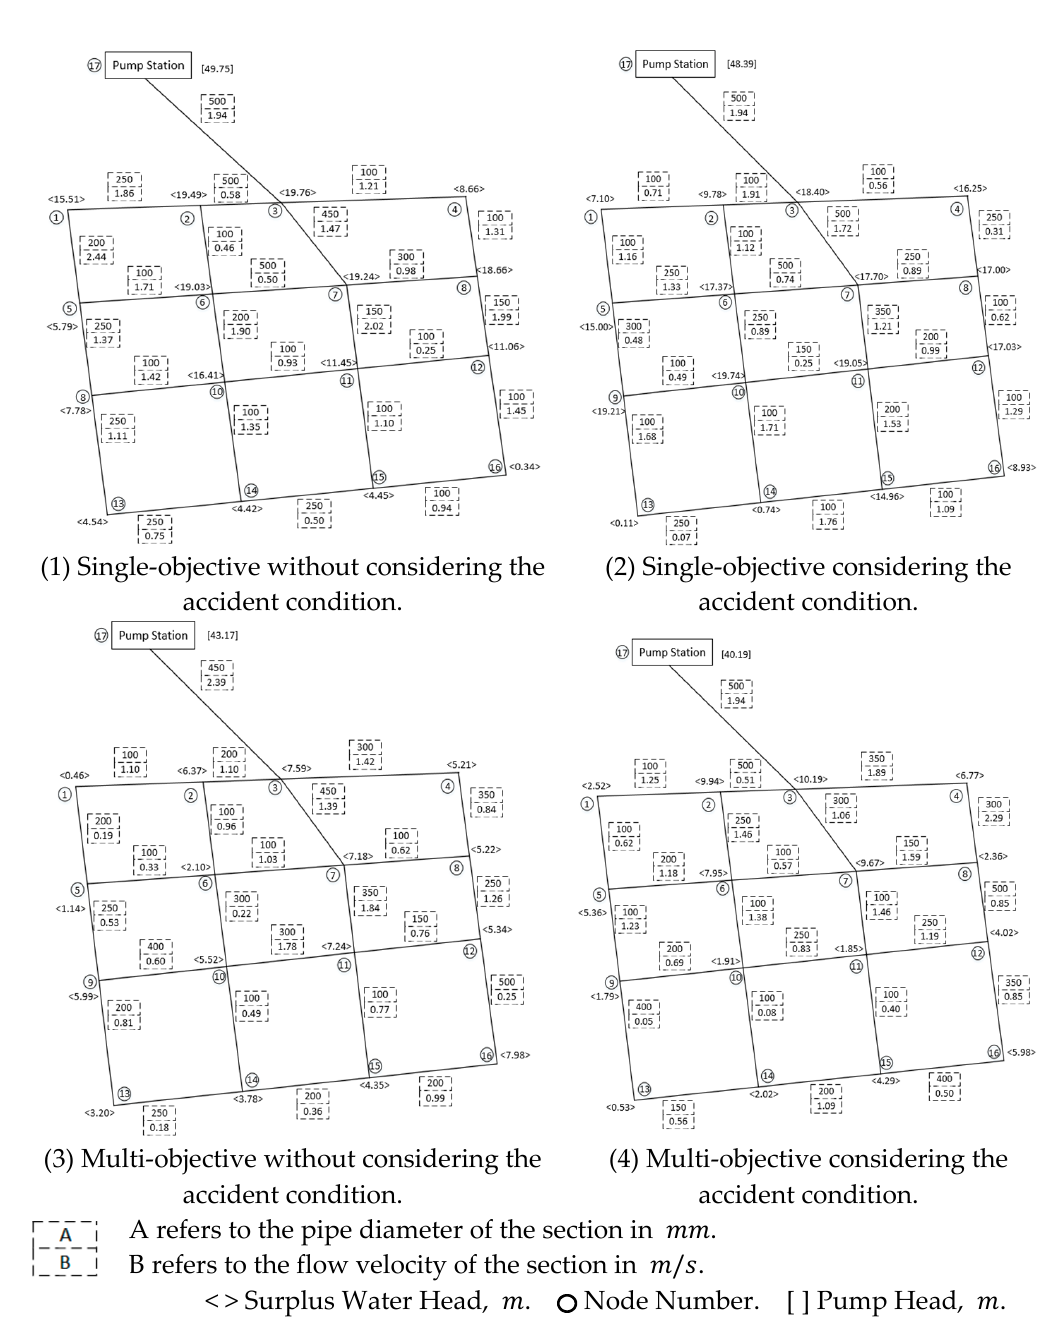
Figure 7. Optimization results of a single pump station water distribution network. Table 2. Comparison of economy and reliability of optimization results of a single pump station water distribution network.